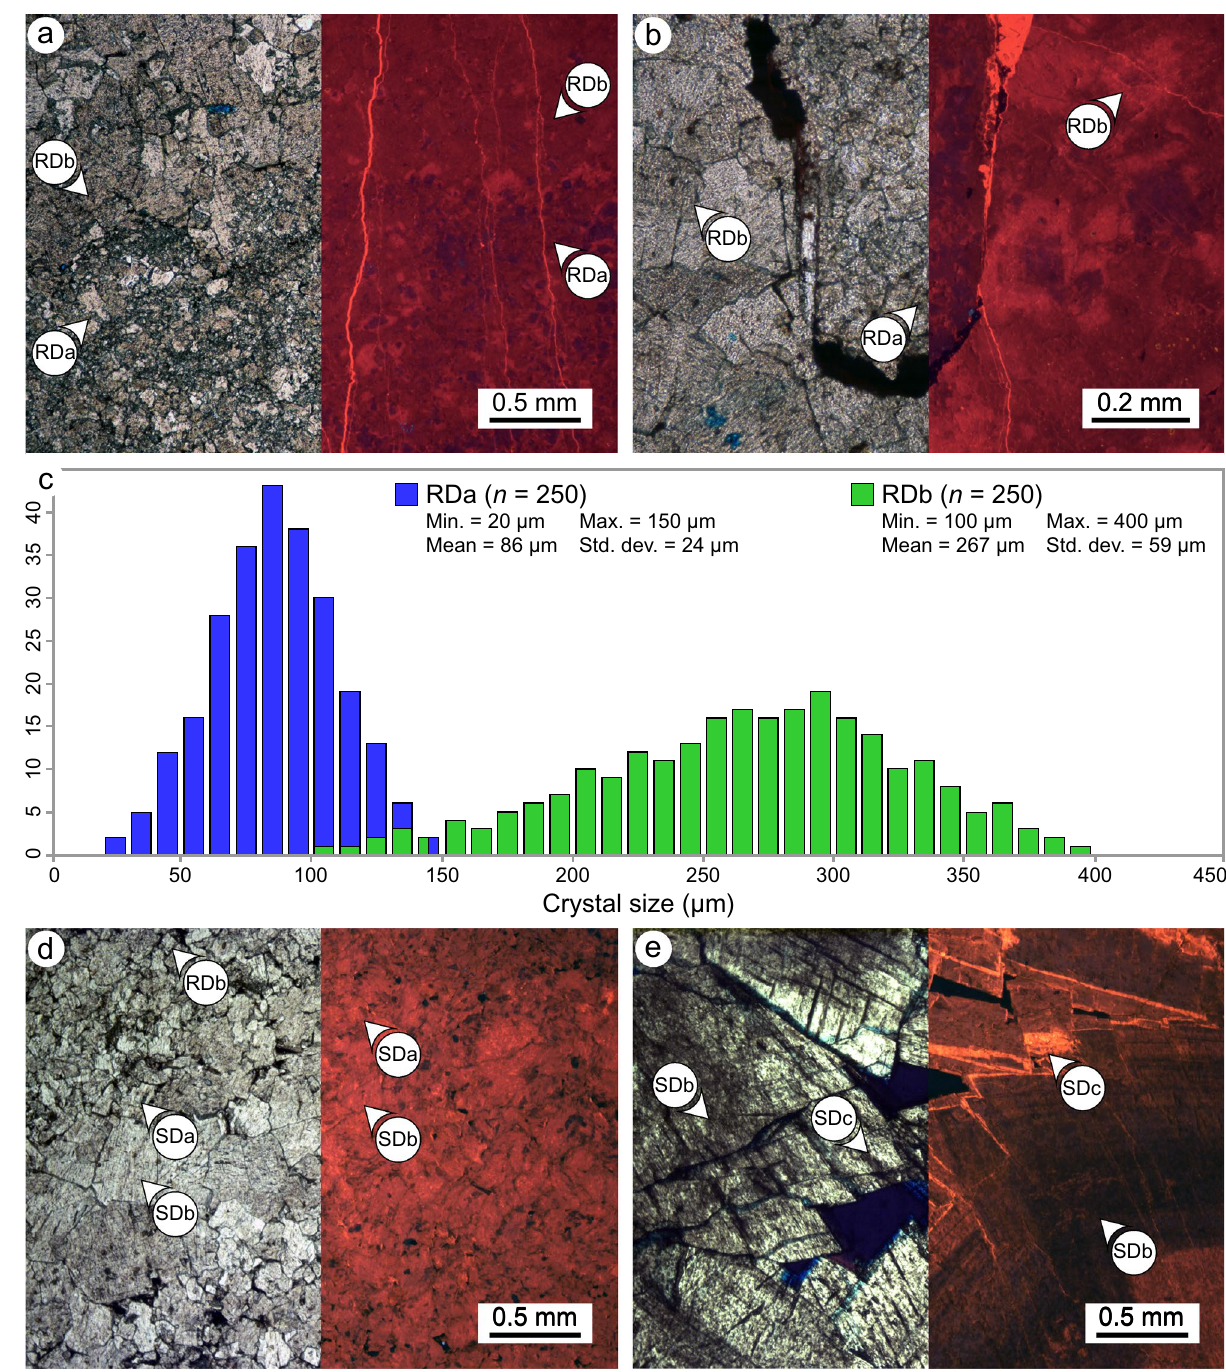
Figure 4. Plane polarized light (PPL; left) and cathodoluminescence (CL; right) photomicrographs of the replacement dolomite (RD) and saddle dolomite (SD) phases in the Cathedral Formation. ( a ) The contact between RDa and RDb showing their respective microscopic features. ( b ) RDa and RDb located above and below a bedding-parallel stylolite, respectively. ( c ) Crystal size histogram for RDa and RDb showing their mean crystal size, range, and standard deviation. Note that the histogram for RDb has a negative skew (− 0.3). ( d ) Bedding-parallel zebra texture showing the gradational increase in crystal size between SDa and SDb and their respective microscopic features. Note that SDa and SDb have similar CL signatures. ( e ) SDc, which commonly form rims nucleated on SDb, comprises alternating zones of dull-red to bright-red luminescent